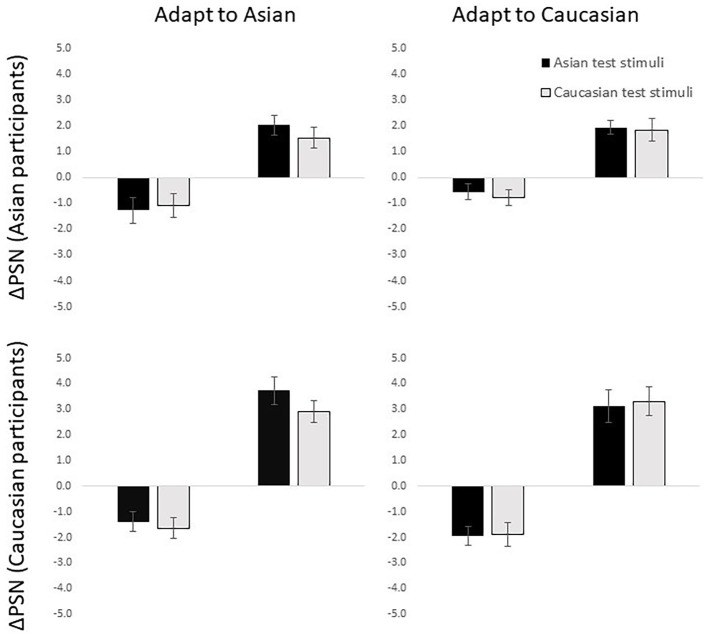
ΔPSN scores for Asian (top) and Caucasian (bottom) participants adjusting Asian (black bars) and Caucasian (light bars) test identities following exposure to Asian (left) and Caucasian (right) adaptation stimuli. Error bars show standard error of the mean.